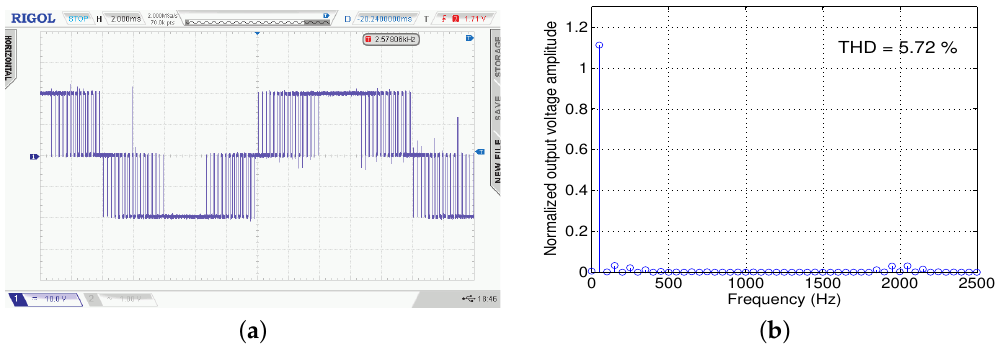
Figure 12. ( a ) Inverter output voltage with SPWM at m I = 1.1 and ( b ) Its frequency